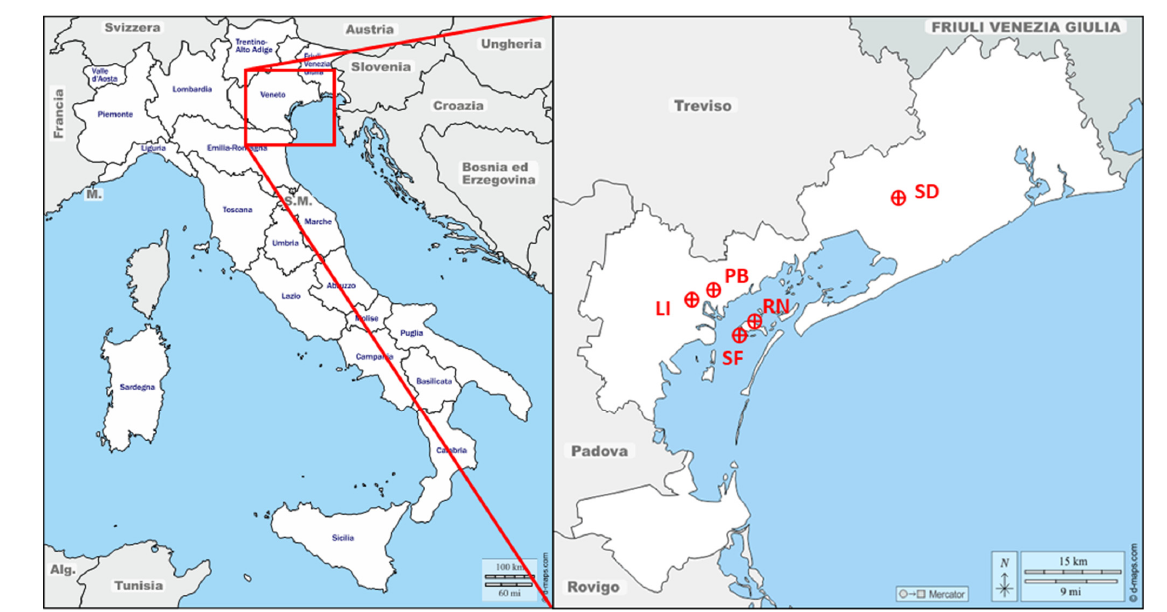
Figure 1. Map of the investigated area. Red dots pinpoint the PM sampling locations in Venice province (VE). LI: Via Lissa; PB: Parco Bissuola; SF: Sacca Fisola; RN: Rio Novo; SD: San Donà (maps from: http://d-maps.com). Table 2. Description of the sample sites.